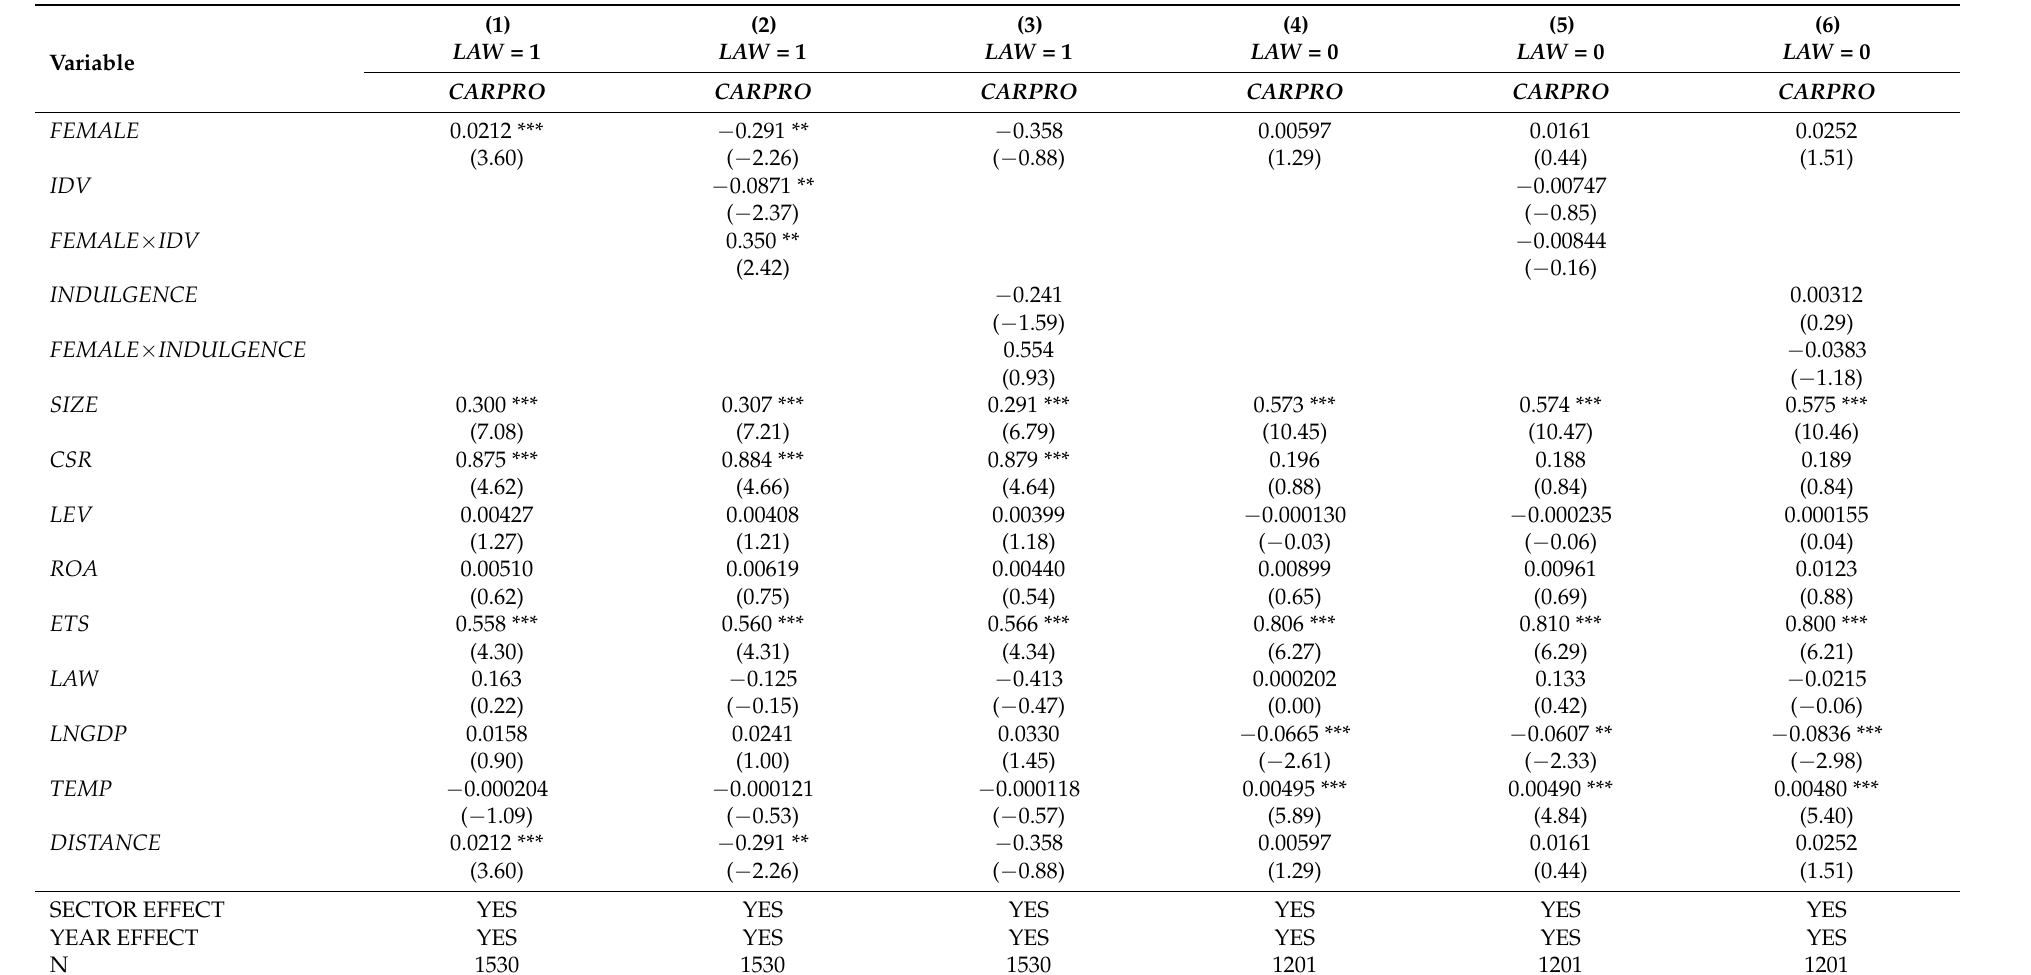
Table 9. Results of subsample analyses based on legal